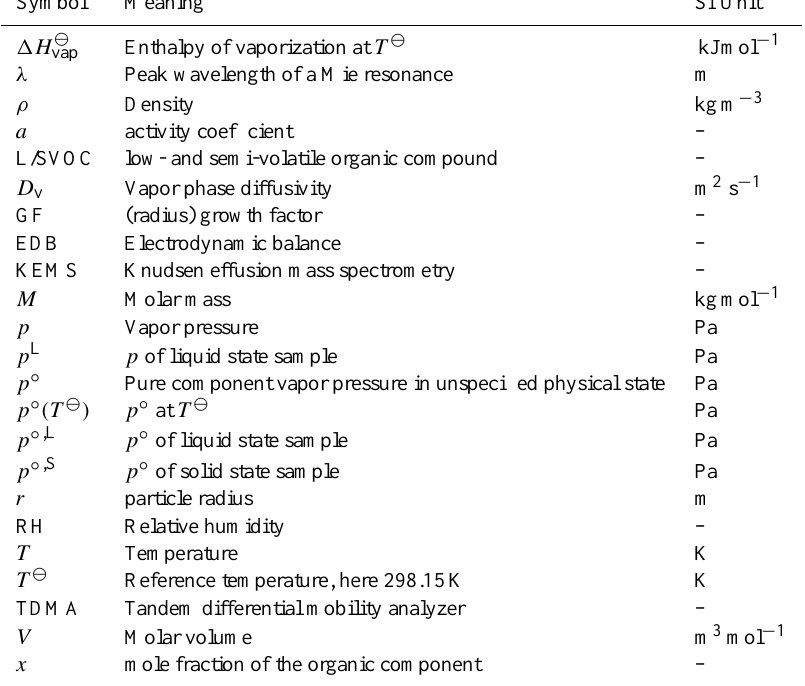
Table E1. List of symbols and abbreviations. Symbol Meaning SI Unit 1H (cid:9) vap Enthalpy of vaporization at T (cid:9)